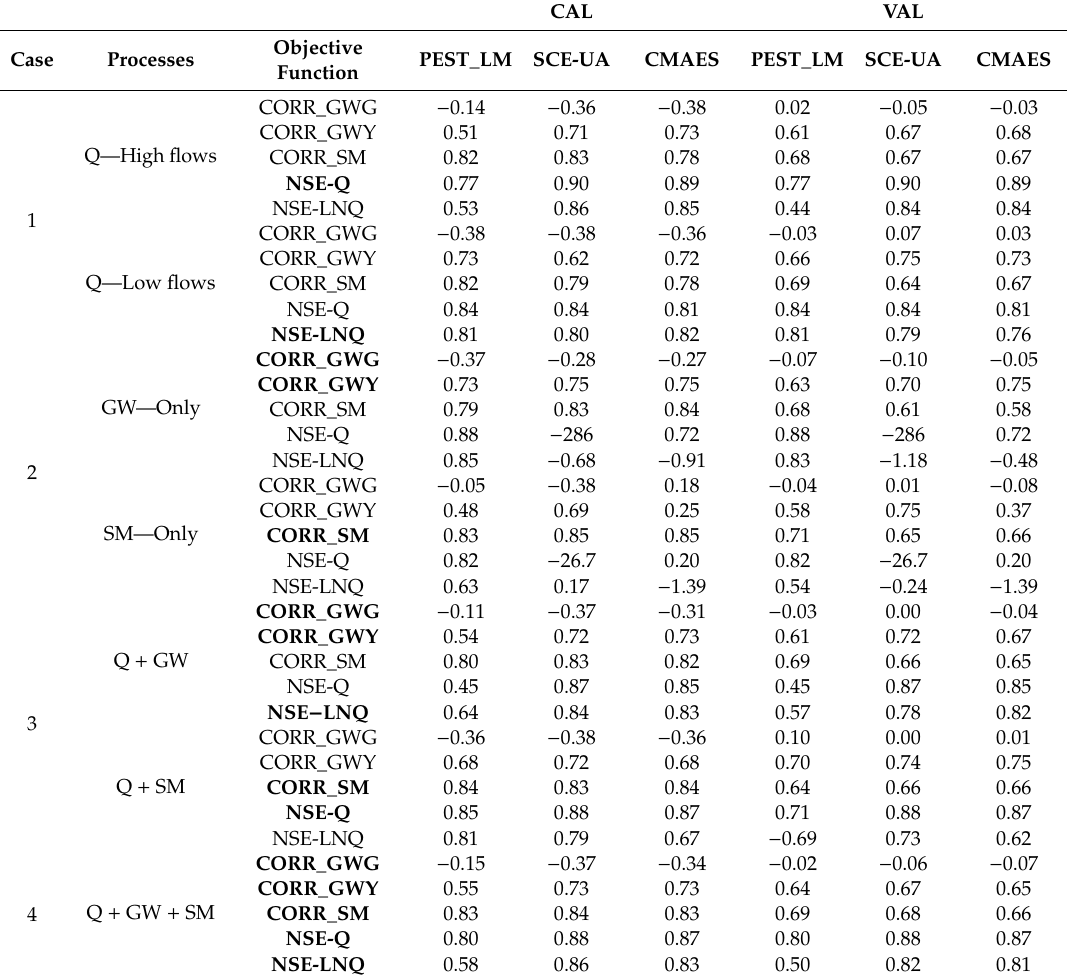
Table 6. Summary of the calibration and validation results for four